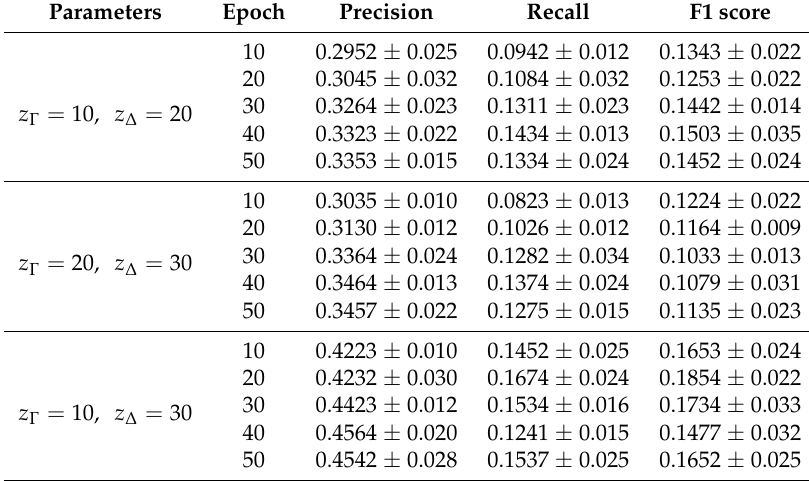
Table 6. Different iteration times to the performance of the classification in LG